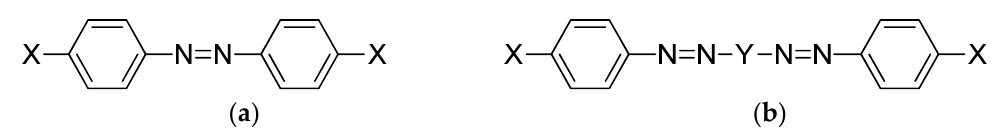
Figure 2. General chemical structure of ( a ) the monoazo linking unit and ( b ) the bisazo linking unit.